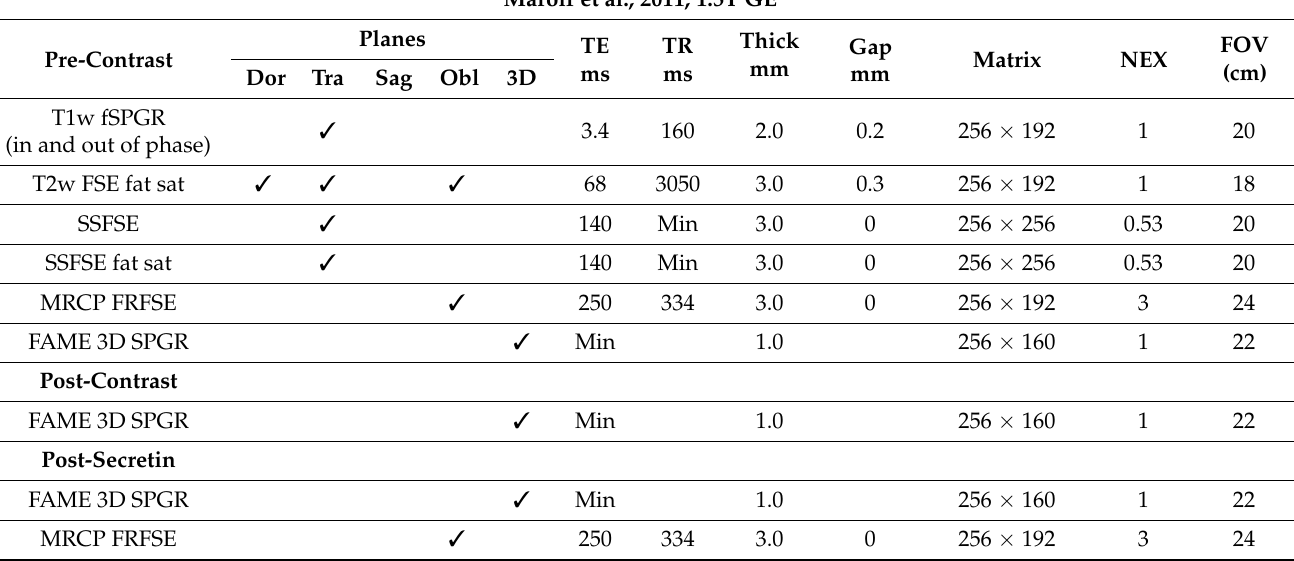
Table 3. MRI and MRCP protocols, including technical details used in Marolf et al., 2011. “Dor” stays for dorsal, “tra” for transverse, “sag” for sagittal, “obl” for oblique, “Min” for minimum, and “Thick” for thickness. Marolf et al., 2011, 1.5T